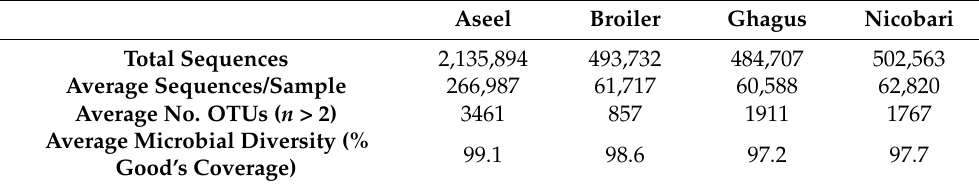
Table 1. Summary statistics of sequences analyzed, operational taxonomic unit (OTU) numbers detected (clustered at >97% similarity), and microbial diversity